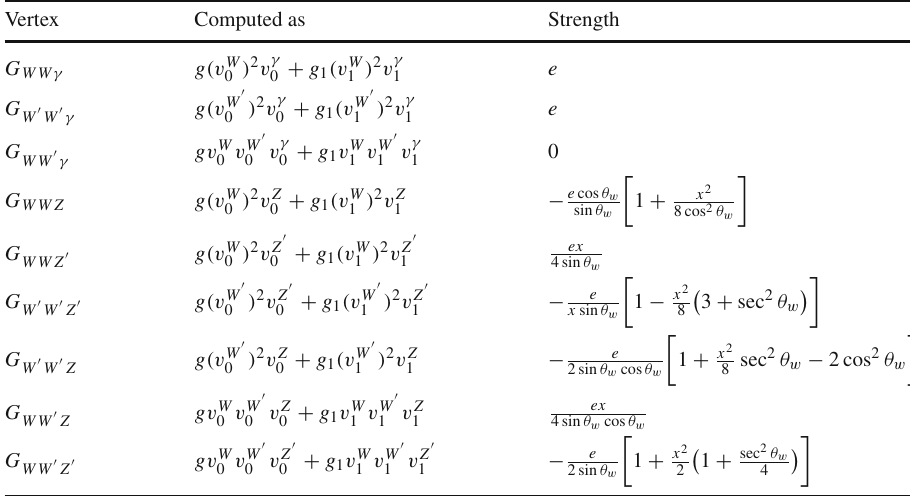
Table 5 Triple gauge boson